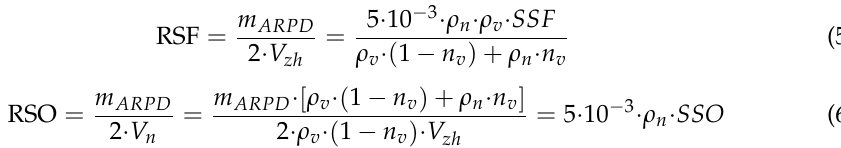
Figure 5. Changes in SSF ( a ) and RSF ( b ) in relation to the associated water mineralization.